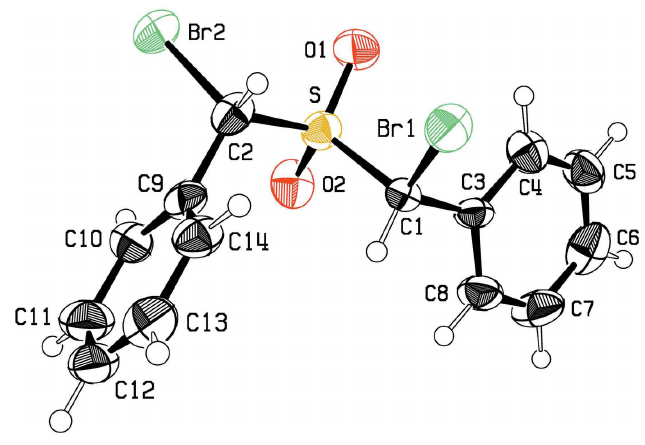
Figure 2 View of the title molecule showing the atomic numbering and displacement ellipsoids at the 50% probability level.